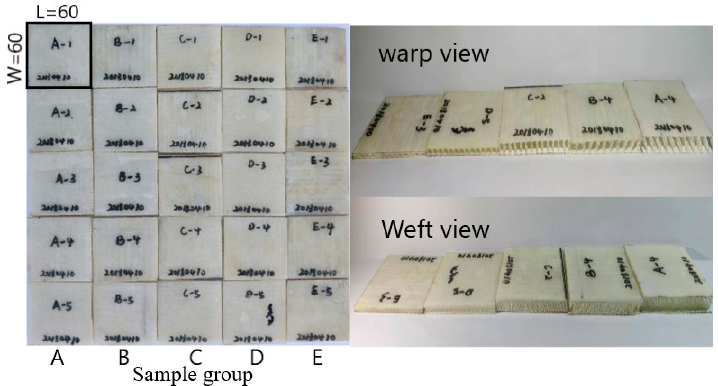
Figure 5. Picture of flat compression specimens.